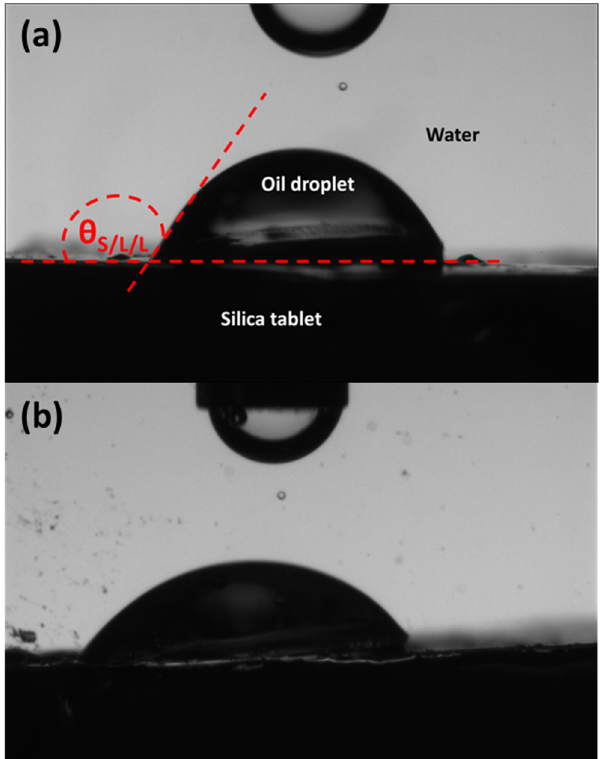
Figure 1. Measurement of the solid/liquid/liquid contact angle ( θ S/L/L ) of ( a ) silica/water/dodecane, and ( b ) silica/water/paraffin.